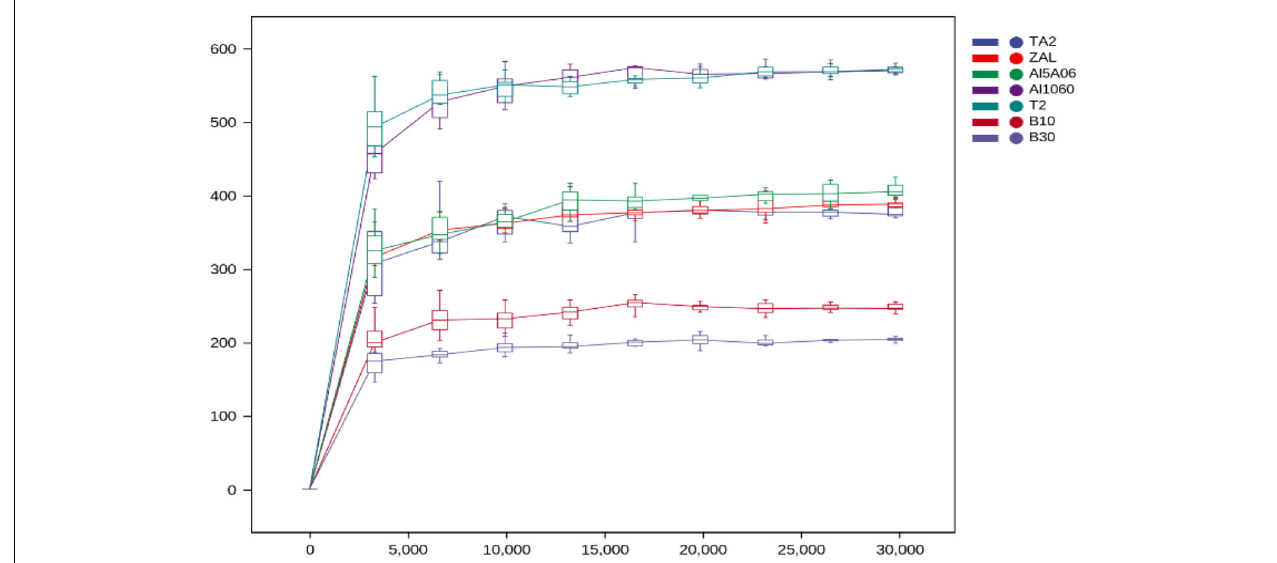
FIGURE 1 | Rarefaction curves of the sequencing reads of the 16S rRNA genes from seven samples in Yap Trench for bacteria at 97% sequence similarity cutoff value (TA2, ZAL, Al5A06, Al1060, T2, B10, and B30 represented the biofilms collected from the corresponding alloy surfaces. The abscissa represented the extraction depth, and the ordinate represented the index and boxplot of the median alpha diversity after 10 calculations. The gentleness of the curve reflected the influence of sequencing depth on the diversity of these samples).